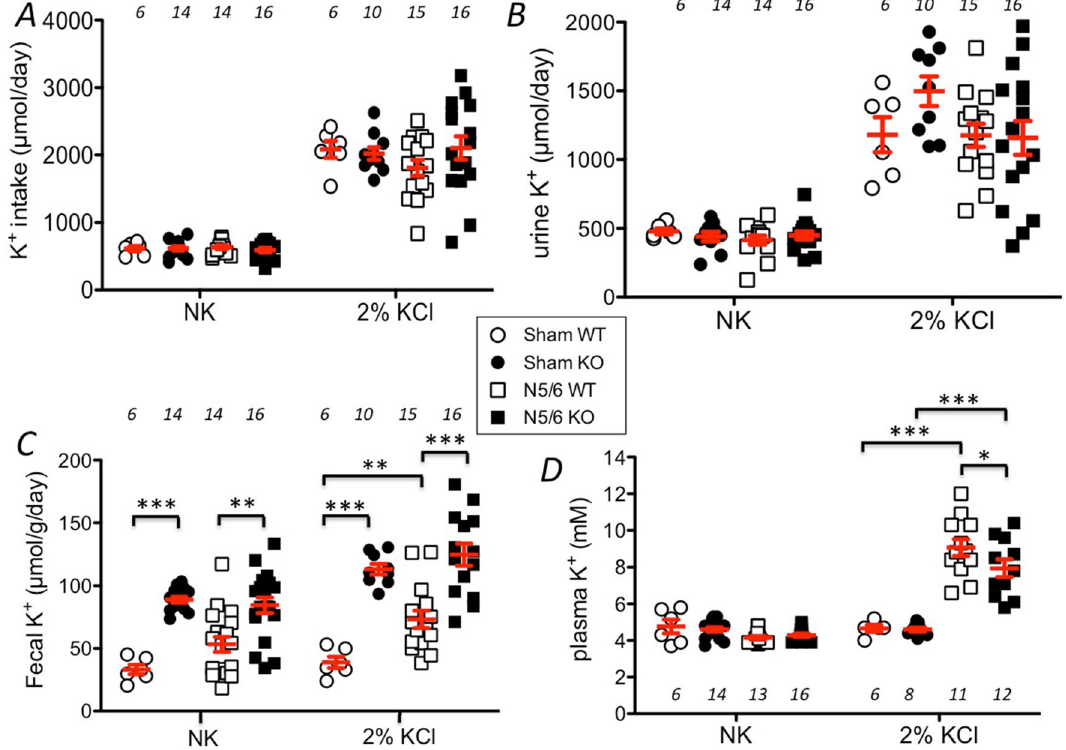
Figure 2. Parameters of the K + balance. The absence of HKA2 limits the increase of plasma K + level. ( A ) Daily K + intake in sham WT (white circles), sham HKA2KO (black circles), N5/6 WT (white squares) and N5/6 HKA2KO (black squares) mice. Results are shown as the mean ± s.e.m. Numbers in italic = n of mice. ( B ) Daily urine K + excretion in sham WT (white circles), sham HKA2KO (black circles), N5/6 WT (white squares) and N5/6 HKA2KO (black squares) mice. Results are shown as the mean ± s.e.m. Numbers in italic = n of mice. ( C ) Daily fecal K + excretion in sham WT (white circles), sham HKA2KO (black circles), N5/6 WT (white squares) and N5/6 HKA2KO (black squares) mice. Results are shown as the mean ± s.e.m. Numbers in italic = n of mice. Two-way ANOVA test followed by a Sidak’s multiple comparisons test, (** p < 0.01; * p < 0.05). D/ Plasma K + value in sham WT (white circles), sham HKA2KO (black circles), N5/6 WT (white squares) and N5/6 HKA2KO (black squares) mice. Results are shown as the mean ± s.e.m. Numbers in italic = n of mice. Two-way ANOVA